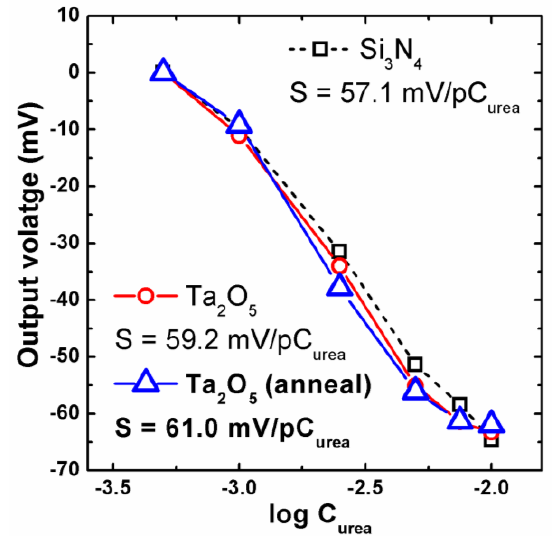
Figure 8. Calibration curves of the urea-EnFETs with Si sensing